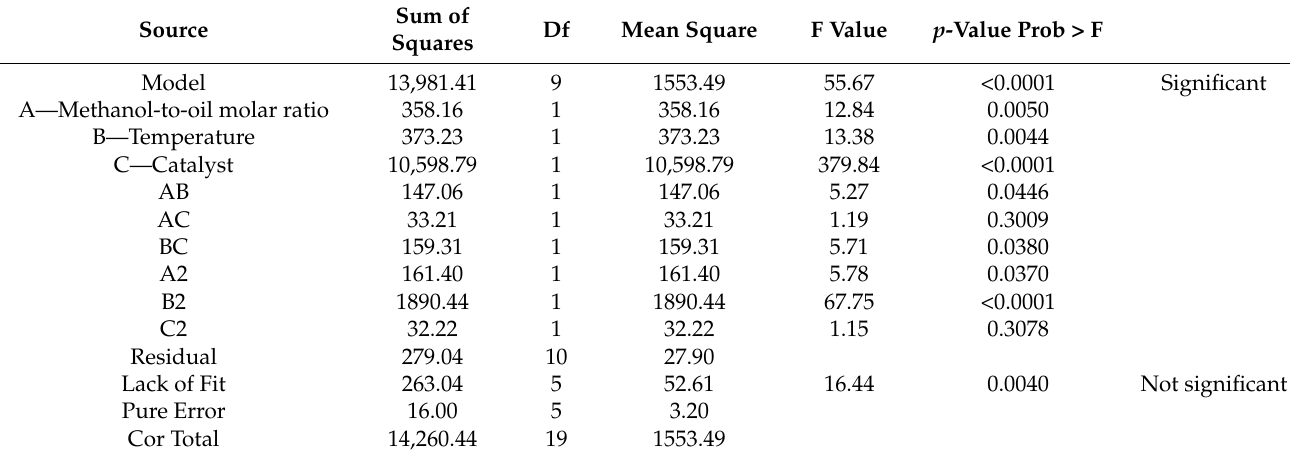
Table 2. Analysis of variance of quadratic model.